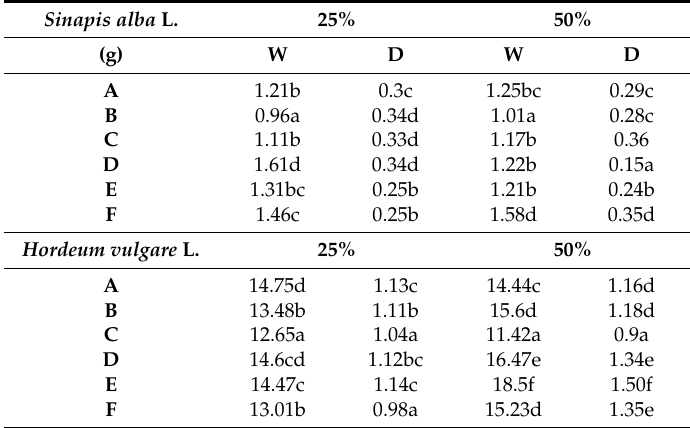
Table 2. Weight biomass of white mustard ( Sinapis alba L.) and barley ( Hordeum vulgare L.). Sinapis alba L. 25% 50% (g)